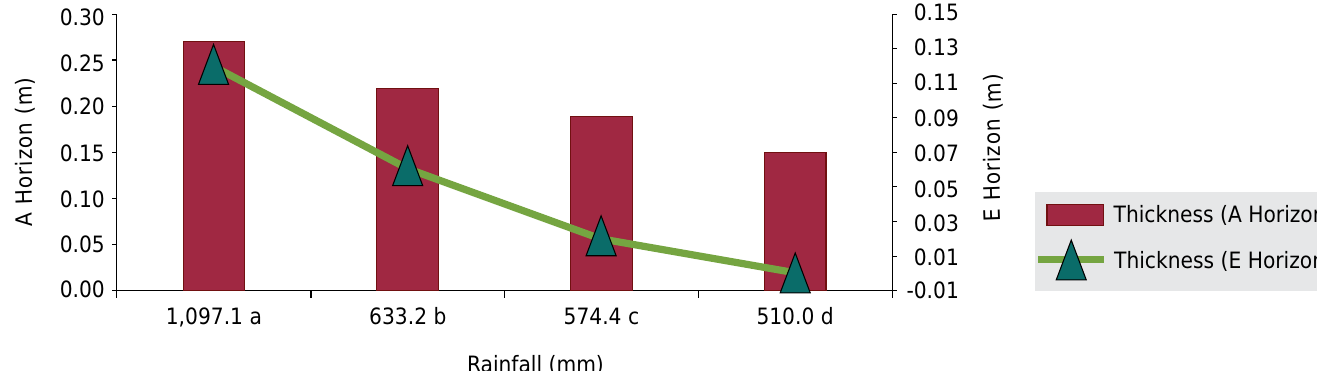
Figure 1. Relationship between rainfall and thickness of horizons A and E in the soils (a – profile 1; b – profile 2; c – profile 3; and d – profile